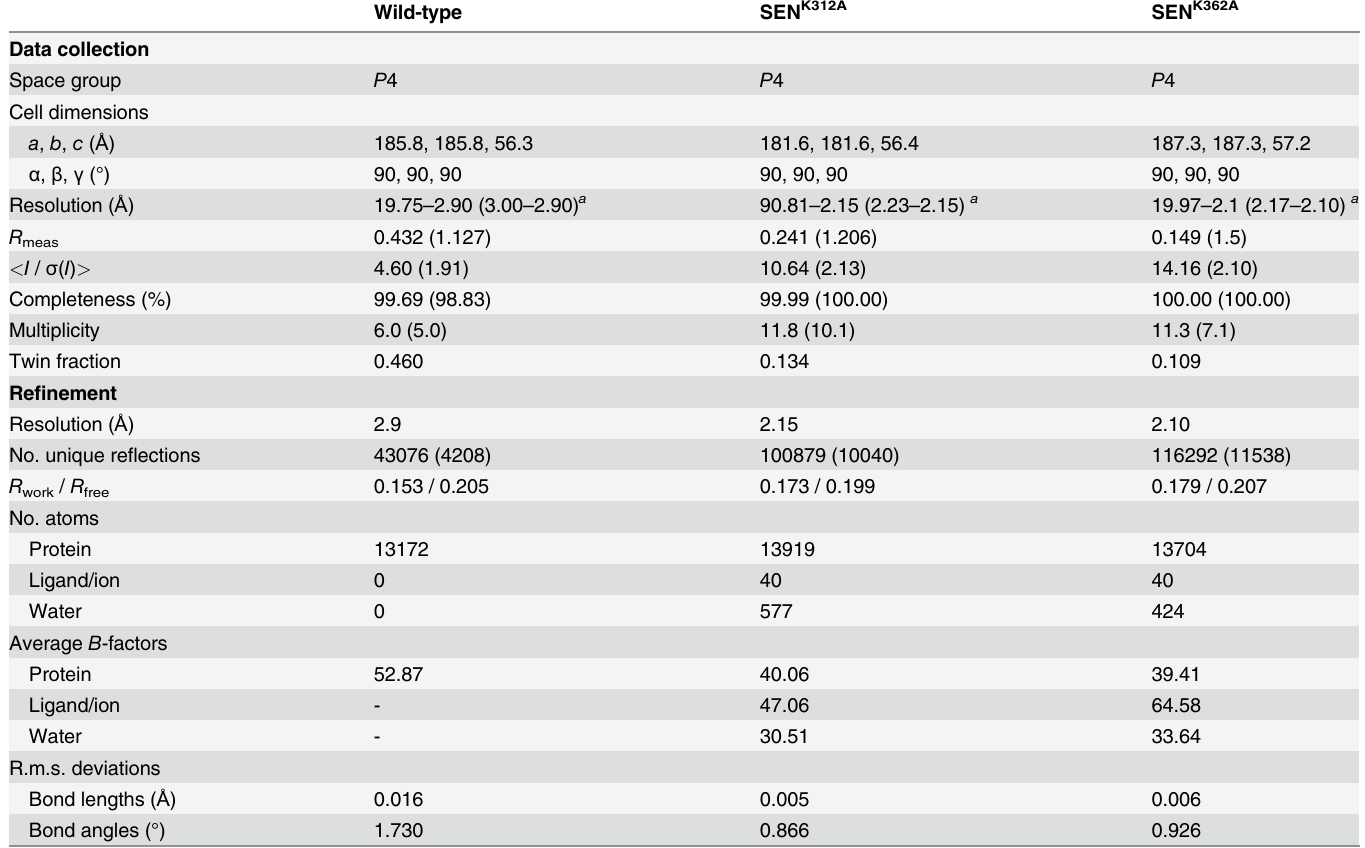
Table 2. Crystallographic data collection and refinement